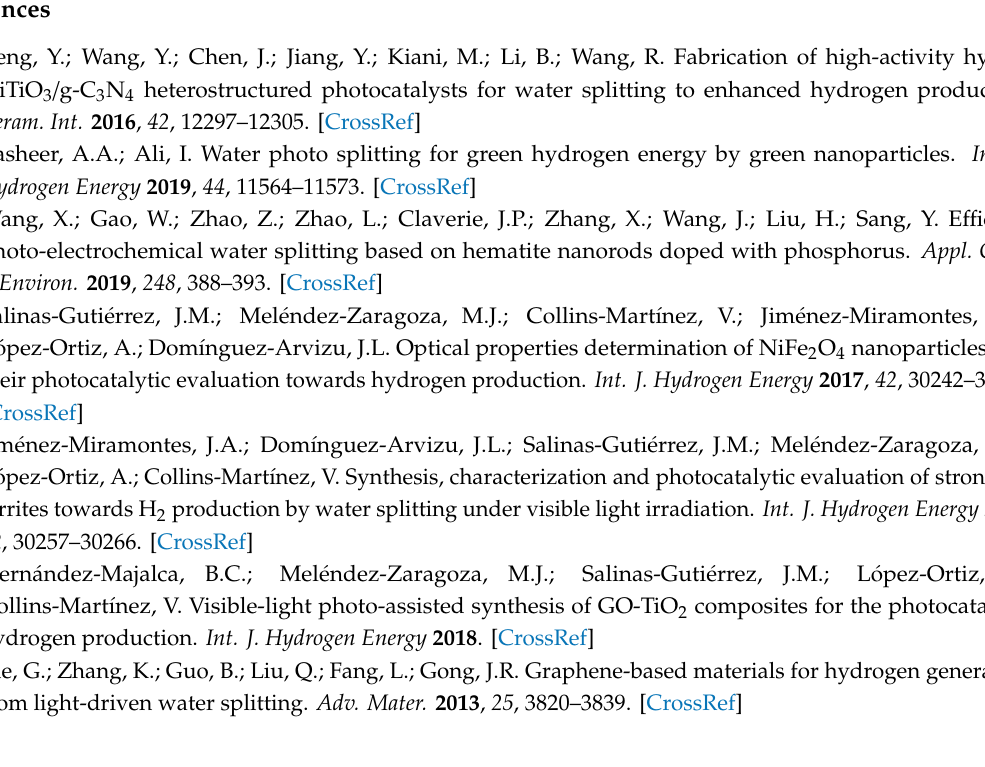
Figure S1: TGA thermal decomposition of (a) citric acid, (b) ethylene glycol, and (c) mixture of citric acid and ethylene glycol, Figure S2: Characterization of the 250W metal halide Philips lamp, Figure S3: Synthesis diagram of ZTO by the modified Pechini method, Figure S4: Experimental setup for photocatalytic activity evaluation